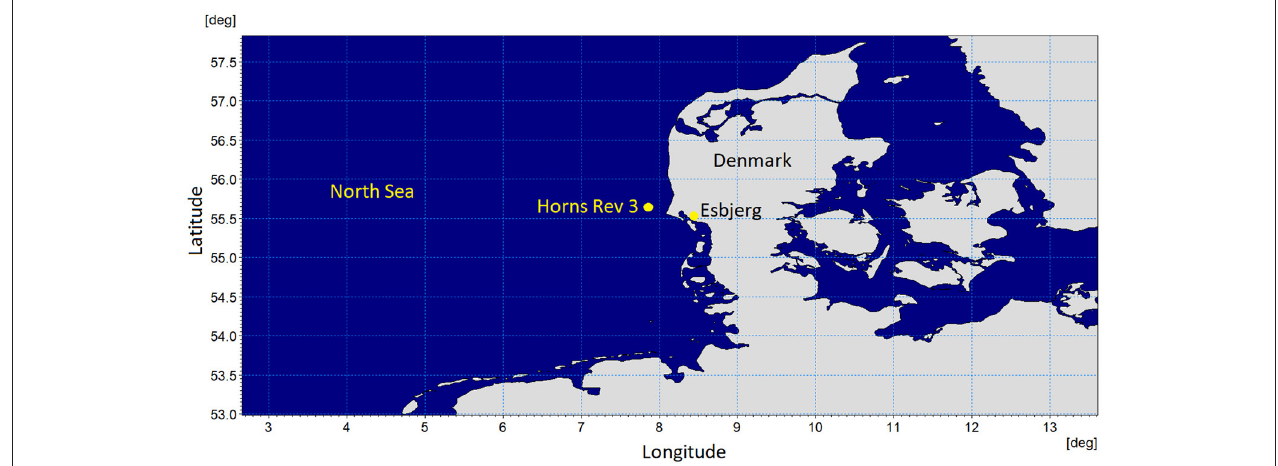
FIGURE 1 | Location of the port of Esbjerg and Horns Rev 3 offshore wind